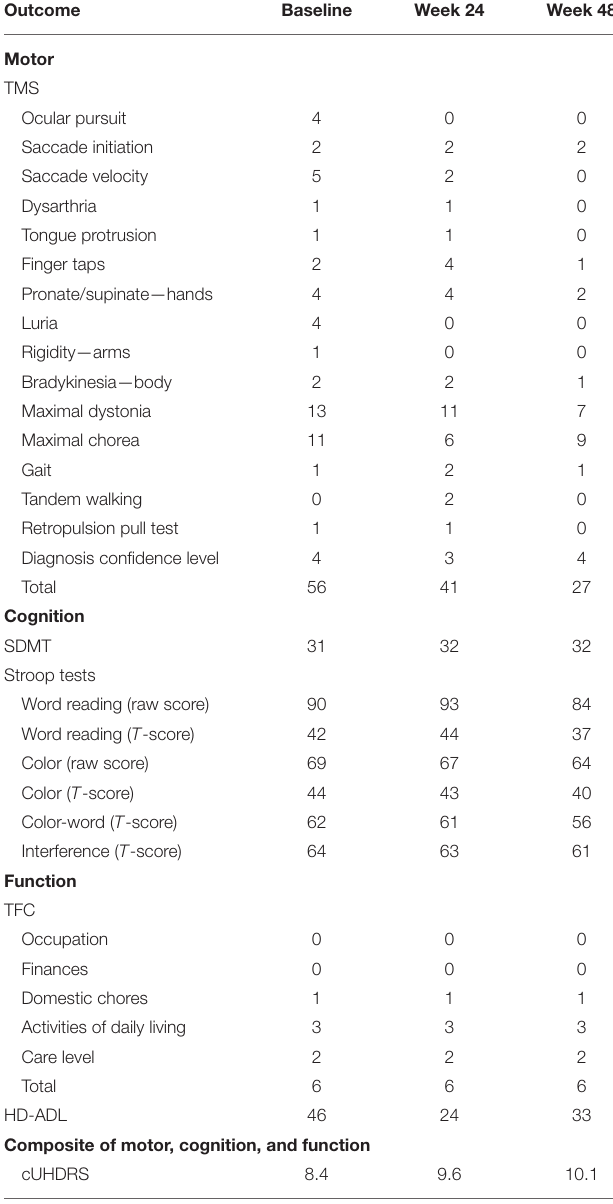
TABLE 1 | Motor, cognitive, and functional outcomes at baseline, 24 weeks, and 48 weeks after commencing the time-restricted ketogenic diet (for the TMS and HD-ADL, lower numbers indicate improved performance, whereas for the SDMT, Stroop Tests, TFC, and cUHDRS, higher numbers indicate improved